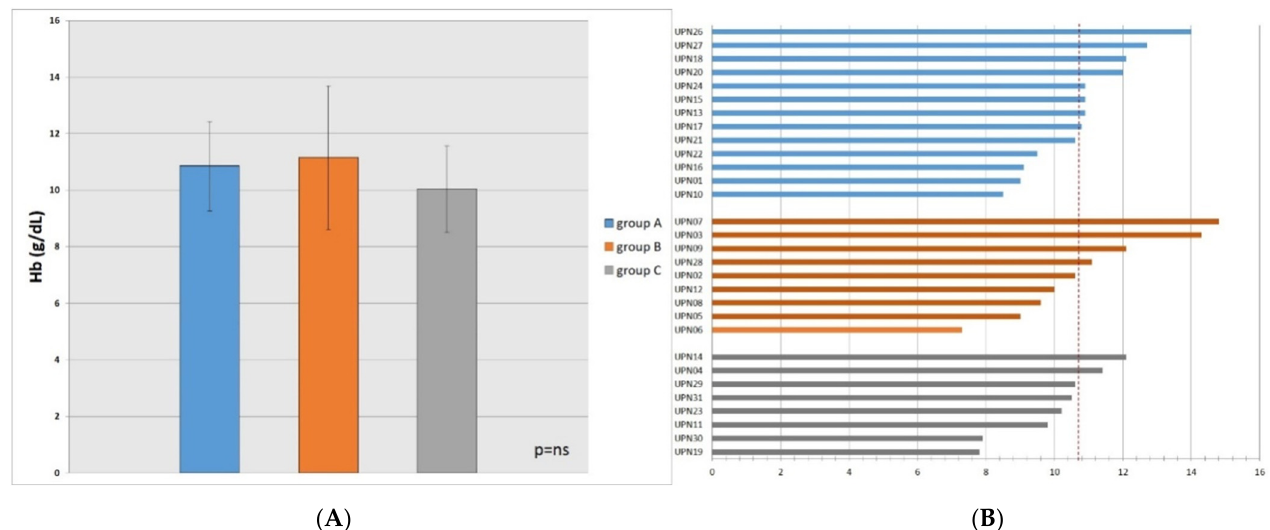
Figure 5. ( A ) Hb levels at week 24th in: group A (patients responding at week 8th), group B (patients who underwent dosage doubling), group C (patients who did not undergo doubling); ( B ) Hb levels at week 24 for each patient. A dashed line indicates a cut-off of Hb level at 10.7 g/dL. ns: not significant .